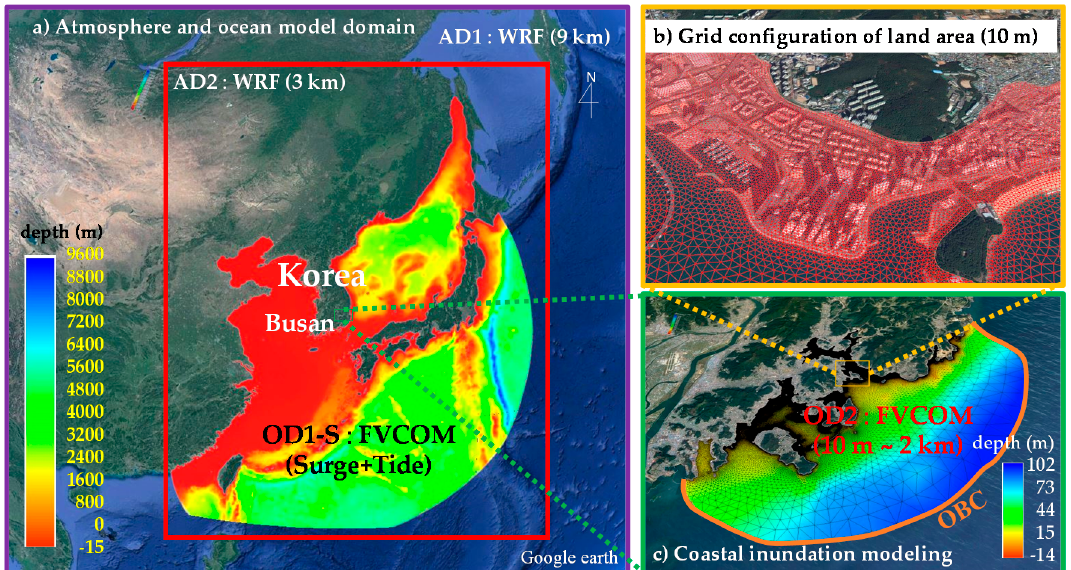
Figure 2. Model description for simulation of typhoon-induced coastal inundation (AD: Atmosphere Domain, OD: Ocean Domain) .